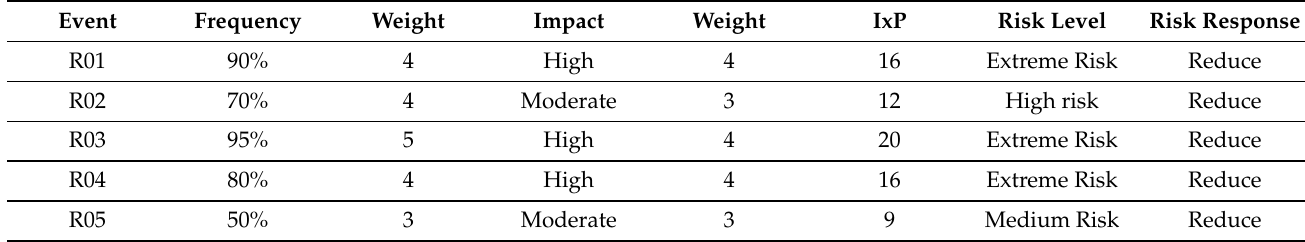
Table 1. Risk Assessment of the Provide ICT Governance